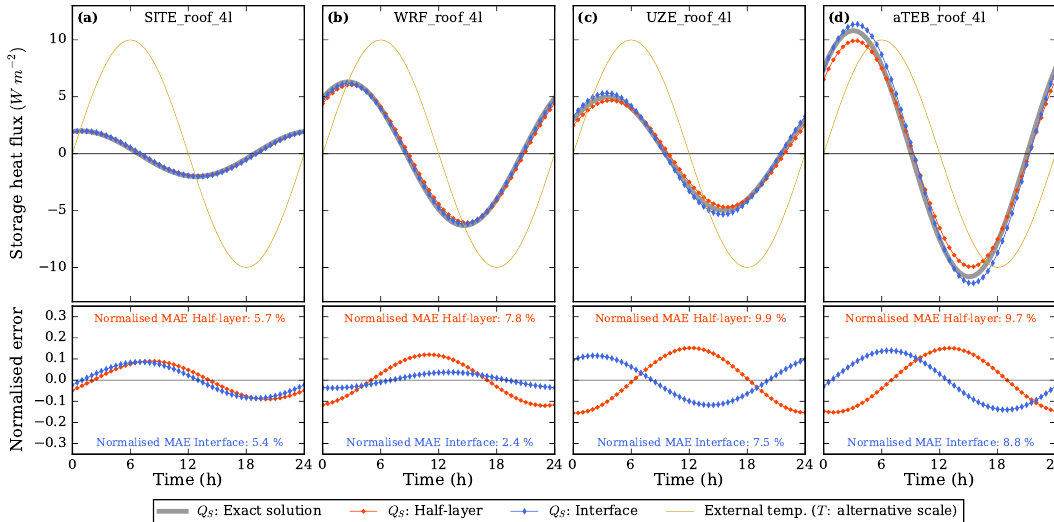
Figure 5. Heat storage response of half-layer and proposed interface schemes vs exact solutions. Material datasets per Fig. 4 and Appendix A. Upper panels show storage heat flux density over a periodic cycle, lower panels show normalised error from exact solutions. The interface scheme reduces errors for these roof representations, but improvements are less pronounced than for walls (Fig. 4).